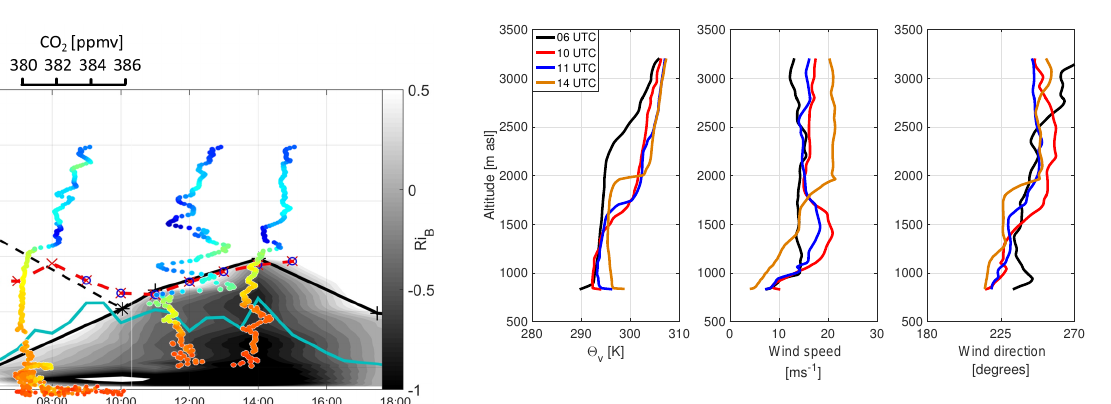
Figure 6. Profiles of (a) virtual potential temperature, (b) wind speed, and (c) wind direction derived from radiosondes during the day (black: 06:00UTC, red: 10:00UTC, blue: 11:00UTC, orange: 14:00UTC) on 6 September